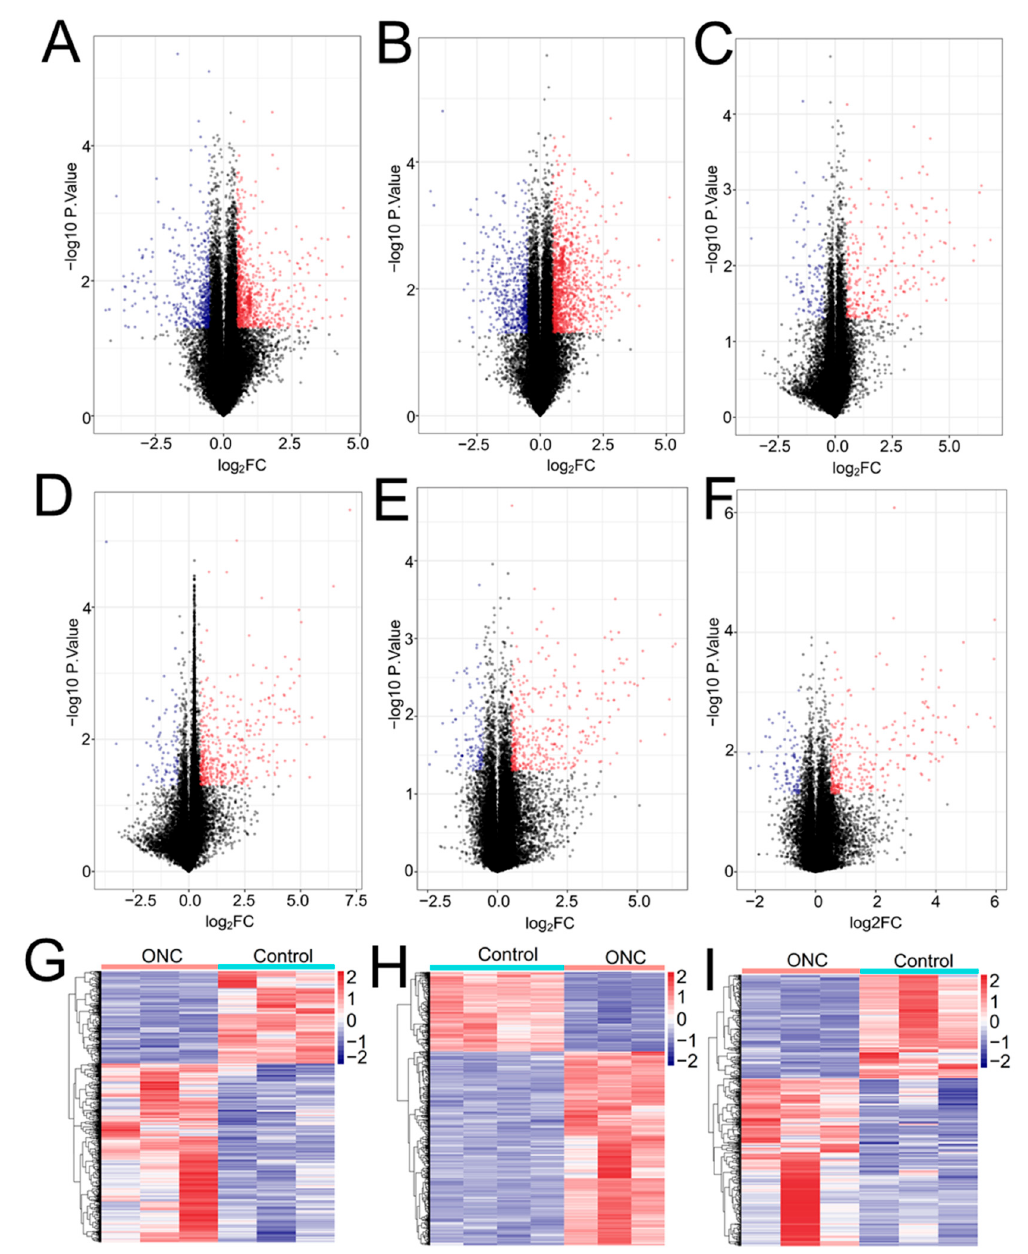
Figure 1. Identification of differentially expressed RNAs. ( A ) a volcano plot to show the differentially expressed RNAs of the GSE49048 dataset with PTC TiO 2 NP exposure; ( B ) a volcano plot to show the differentially expressed RNAs of the GSE49048 dataset with 10PTC TiO 2 NP exposure; ( C ) a volcano plot to show the differentially expressed RNAs of the GSE49371 dataset with Au20 NP exposure; ( D ) a volcano plot to show the differentially expressed RNAs of the GSE49371 dataset with Au100 NP exposure; ( E ) a volcano plot to show the differentially expressed RNAs of the GSE49371 dataset with Si20 NP exposure; ( F ) a volcano plot to show the differentially expressed RNAs of the GSE49371 dataset with Au100 NP exposure; ( G ) a heat map to show the differentially expressed RNAs of the GSE55228 dataset undergoing ONC procedures; ( H ), a heat map to show the differentially expressed RNAs of the GSE120257 dataset undergoing ONC procedures; ( I ) a heat map to show the differentially expressed RNAs of the GSE131486 dataset undergoing ONC procedures. Blue dots in the volcano plots are downregulated genes; red dots in the volcano plots are upregulated genes; blue in the heatmap indicates high expressed genes; red in the heatmap indicates low expressed genes; FC, fold